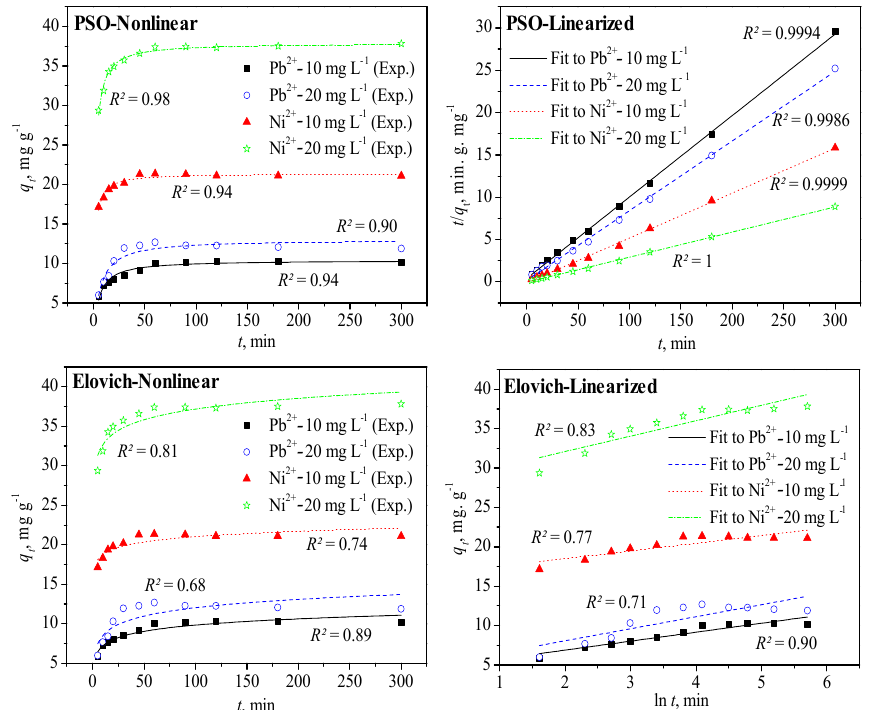
Figure 4. Fitting of the pseudo-second-order (PSO) and Elovich kinetic models to the adsorption data of Pb 2+ and Ni 2+ on PANmod at different initial